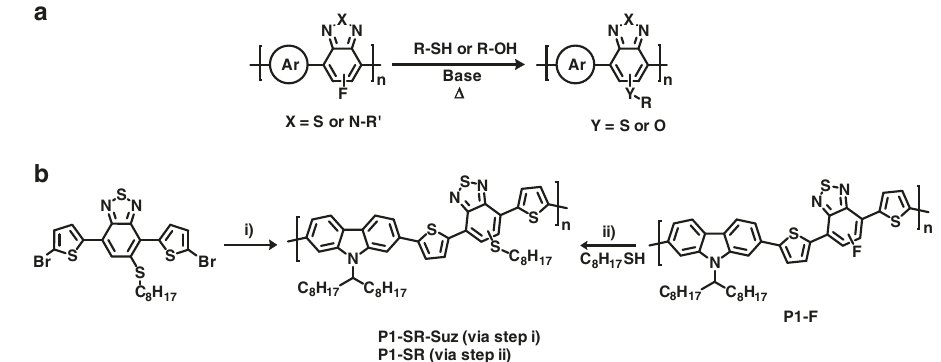
Fig. 1 General reaction scheme and example reaction. a Scheme for the modi fi cation of semiconducting polymers containing either fl uorinated benzotriazole or benzothiadiazole comonomers with a thiol or alcohol. b Synthesis of P1-SR from two different strategies: (i) 9-(9-heptadecanyl) − 9H- carbazole-2,7-diboronic acid bis(pinacol) ester, Pd(PPh 3 ) 4 , toluene, Na 2 CO 3 (aq), 120 °C 3 days. (ii) 120 °C 30 min (microwave), excess Na 2 CO 3 , 3:1 (v:v) Chlorobenzene